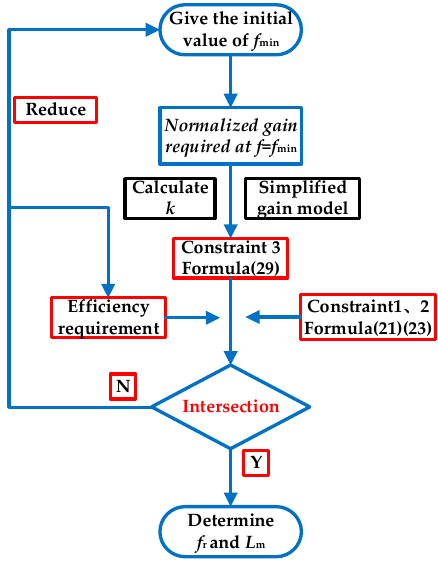
Figure 5. Flow chart for the optimal design of the parameters.